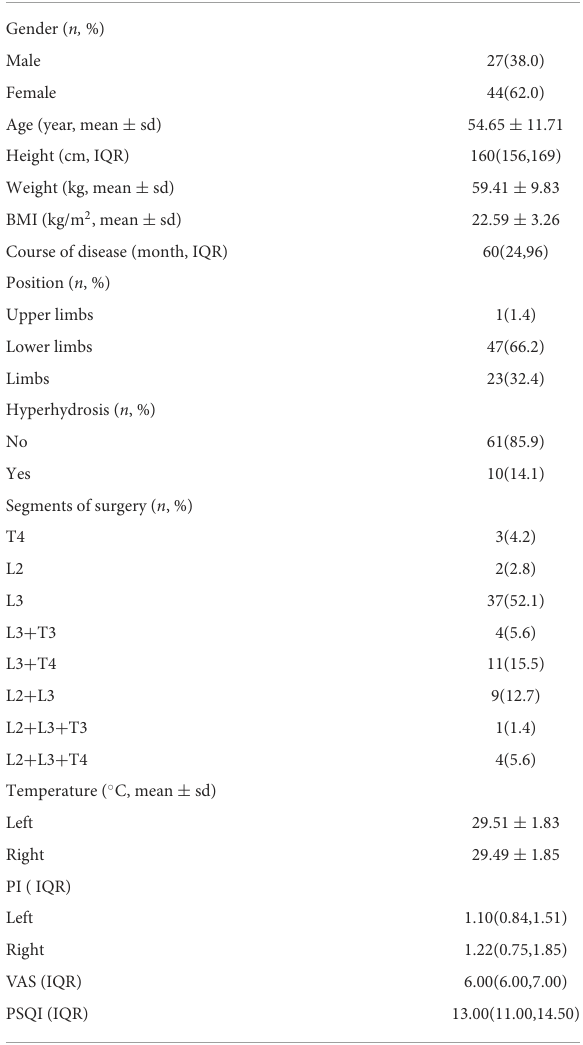
TABLE 1 Characteristics of